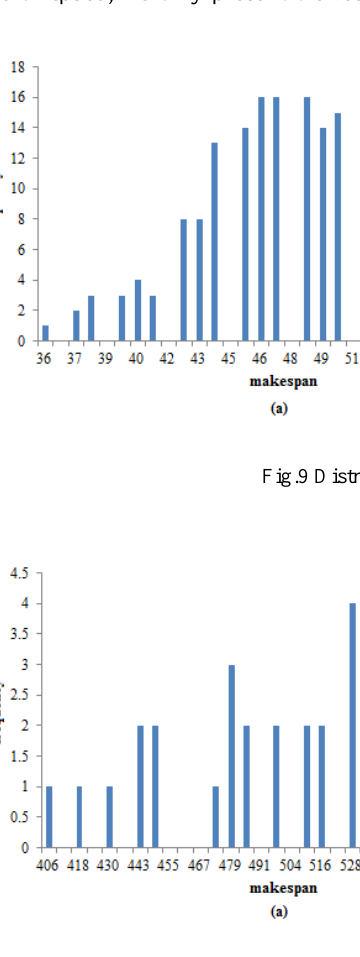
Fig.10 Distribution of makespan and RM when OS = 0.9 and RC =